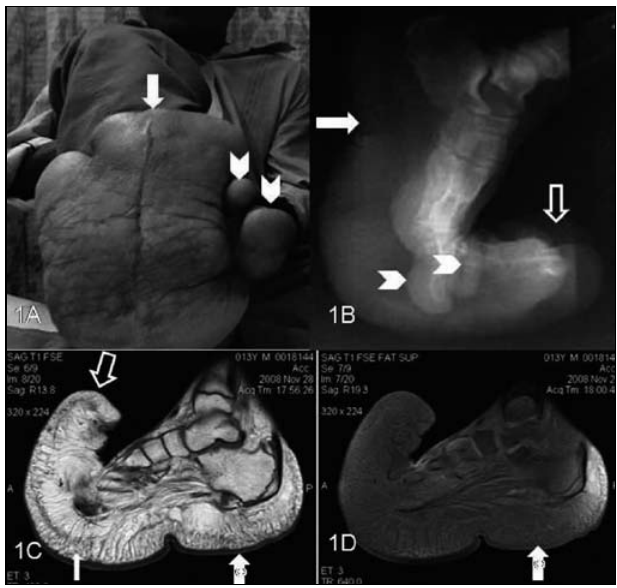
Fig. 1A. Photograph showing swelling on the plantar aspect of the right foot (white arrow). First and 2nd digits are spared (white arrow heads). Fig. 1B. Plain skiagram of right foot revealing hyperextension of the 3rd, 4th and 5th metatarsophalangeal joints ( open white arrow), with overgrowth of distal phalanges. First and 2nd digits are seen normally (white arrow heads). Fig. 1C. T1W sagittal image of right foot revealing diffused thickening of soft tissue (thick white arrow) appearing heterogeneously hyperintense with multiple thin linear low-signal intensity areas consistent with fibrous strands ( thin white arrow). Hyperextension is seen at metatarsophalangeal joints ( open white arrow). Fig. 1D. T1W fat-suppressed sagittal image of right foot shows suppression of the signal from the unencapsulated fat (white arrow).